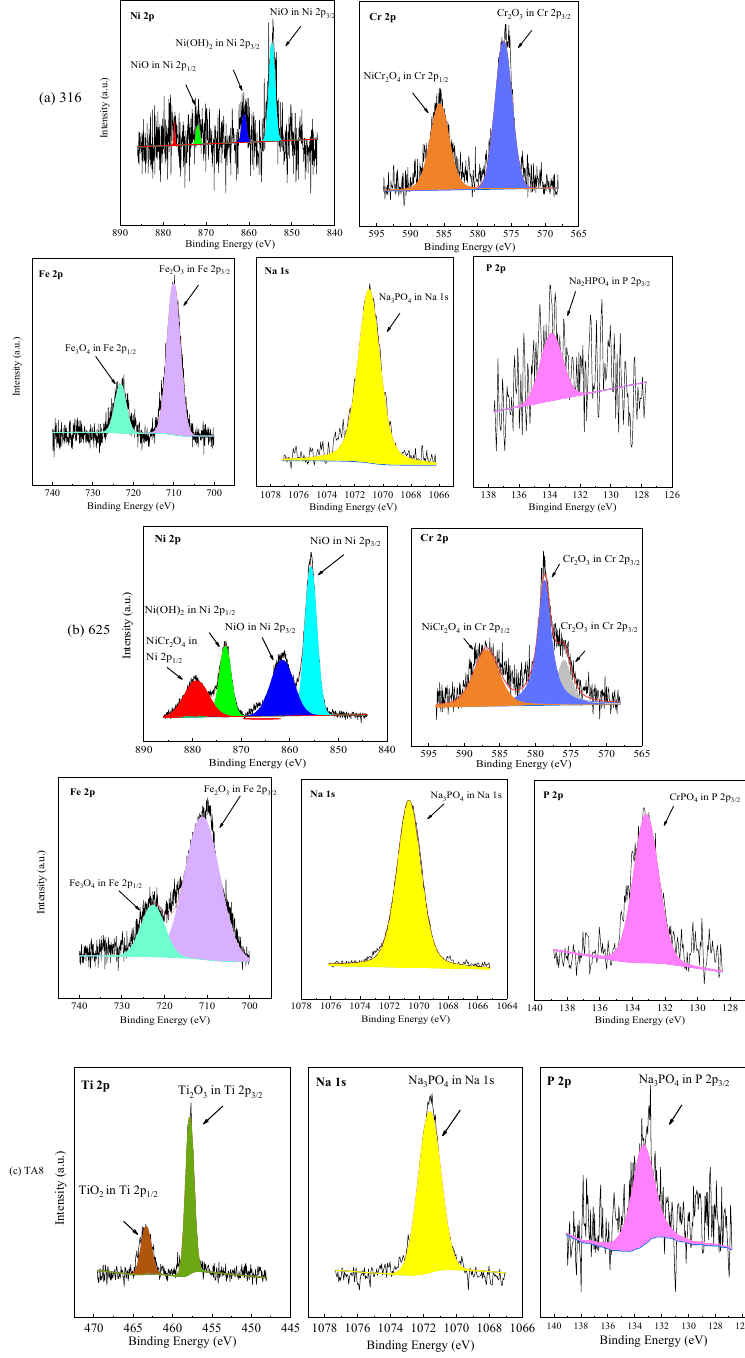
Figure 6. XPS patterns of the specimens at the bottom of the reaction tube after exposure to SCW for 200 h, respectively; (a) 316 SS at the bottom reaction tube; (b) Alloy 625 at the bottom reaction tube; (c) TA8 at the bottom reaction tube.